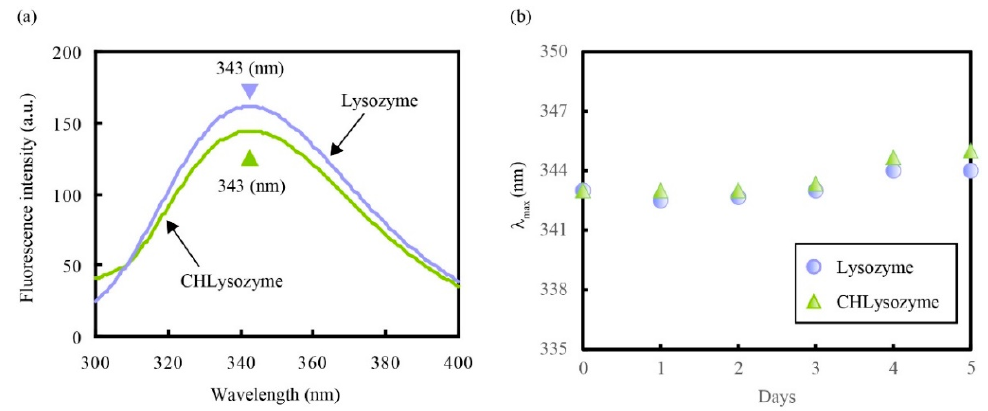
Figure 5. Fluorescence emission spectra ( a ) and λ max change against time ( b ) of lysozyme and CHLysozyme at 25 °C. CHLysozyme concentration: 0.2 mg/mL. Excitation wavelength: 280 nm. Gain value of fluorescence spectrometer: medium.